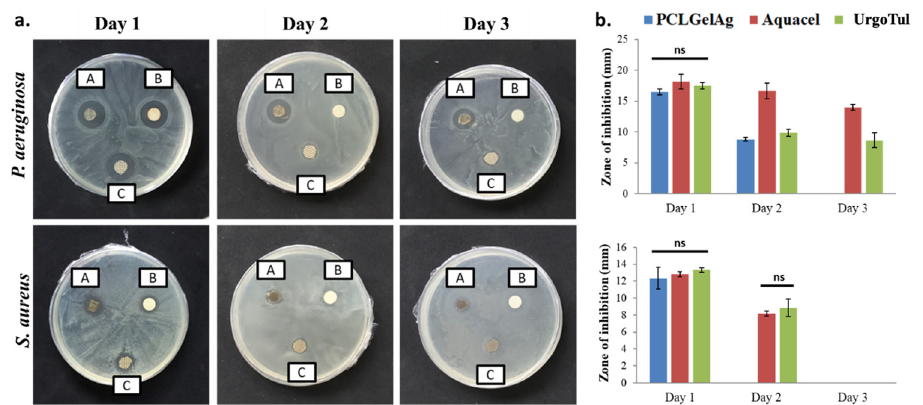
Figure 3. ( a ) Inhibition zones and ( b ) average zone diameters of the three wound dressing disks: (A) Aquacel, (B) PCLGelAg, and (C) UrgoTul against P. aeruginosa and S. aureus. The disks were transferred to a new agar plate every 24 h for 3 days. ns: not significant.